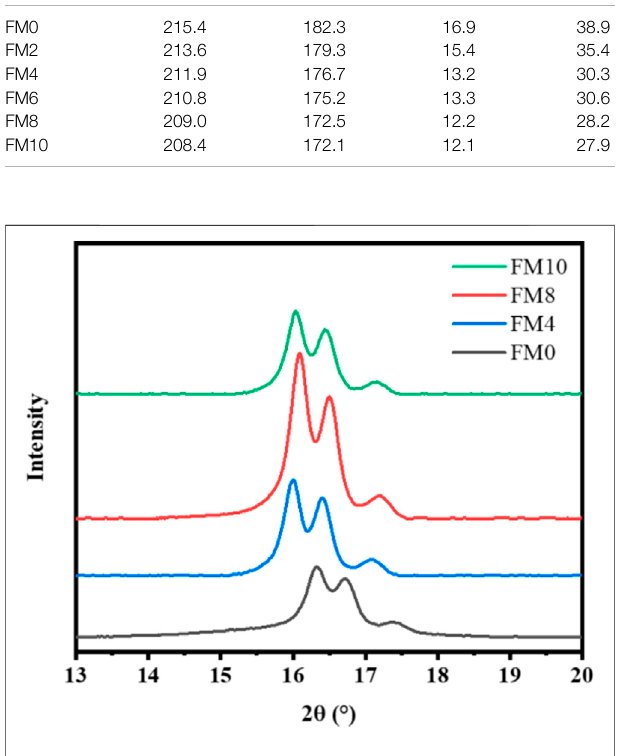
FIGURE 5 | WAXD patterns of neat PCTFE and its blending samples with different FCO contents.